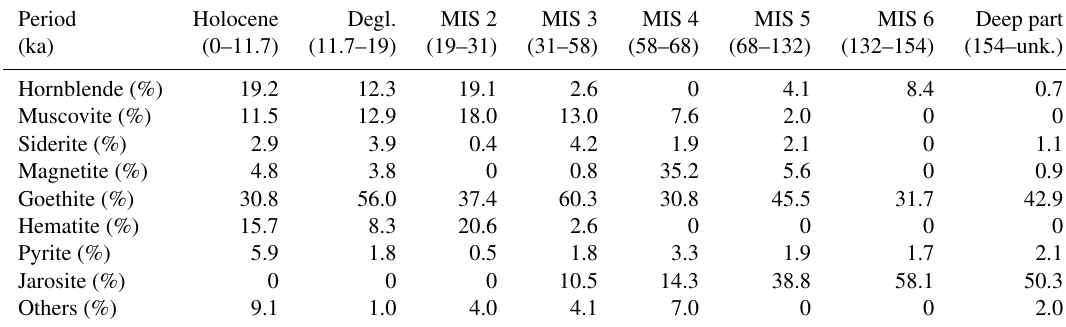
Table 3. Average relative abundance of Fe-bearing minerals in TALDICE dust. Data are expressed as percent